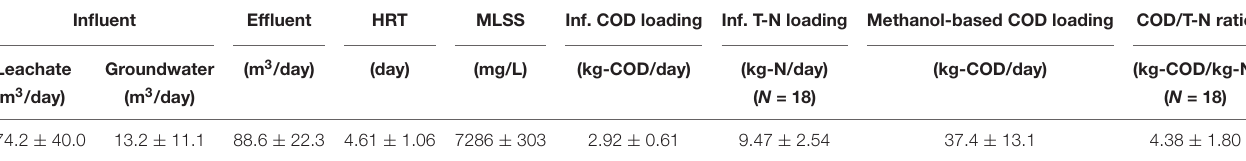
Supplementary Figure 1 ) and repertories of